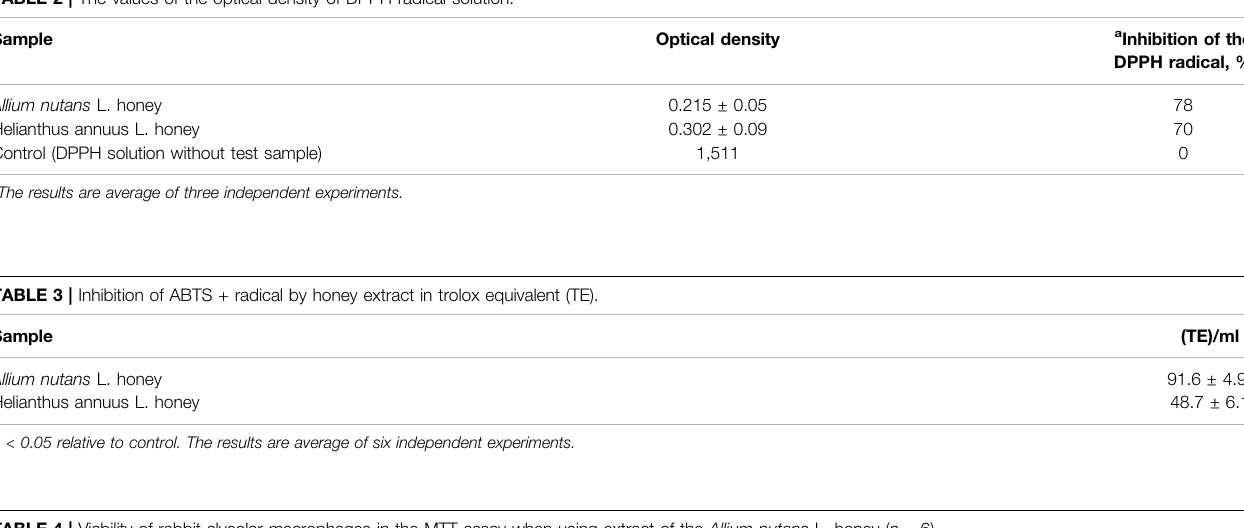
TABLE 4 | Viability of rabbit alveolar macrophages in the MTT assay when using extract of the Allium nutans L. honey ( n (cid:2) 6).